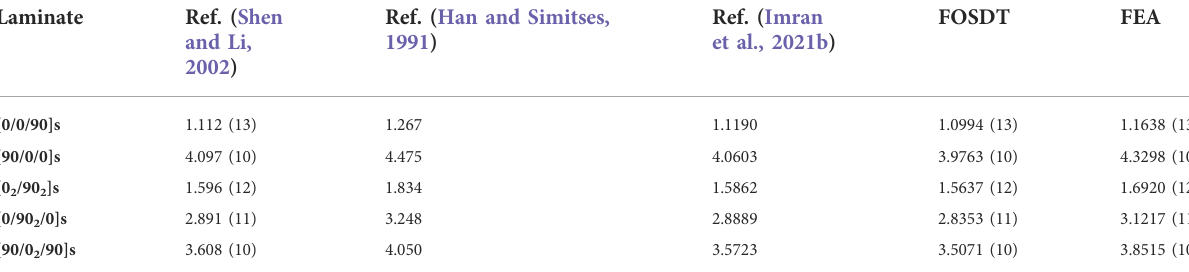
TABLE 3 Results of buckling pressure (psi) from veri fi cation example 2.